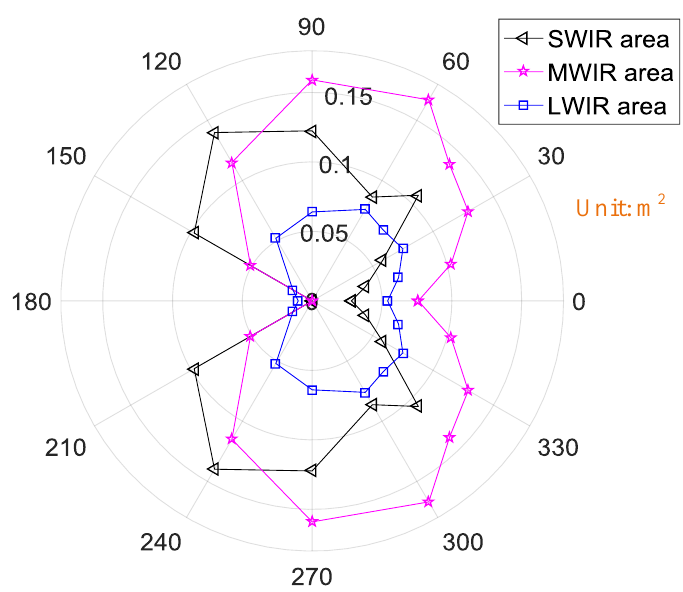
Figure 16. Orientation map of the UAV’s radiation areas in different IR bands.